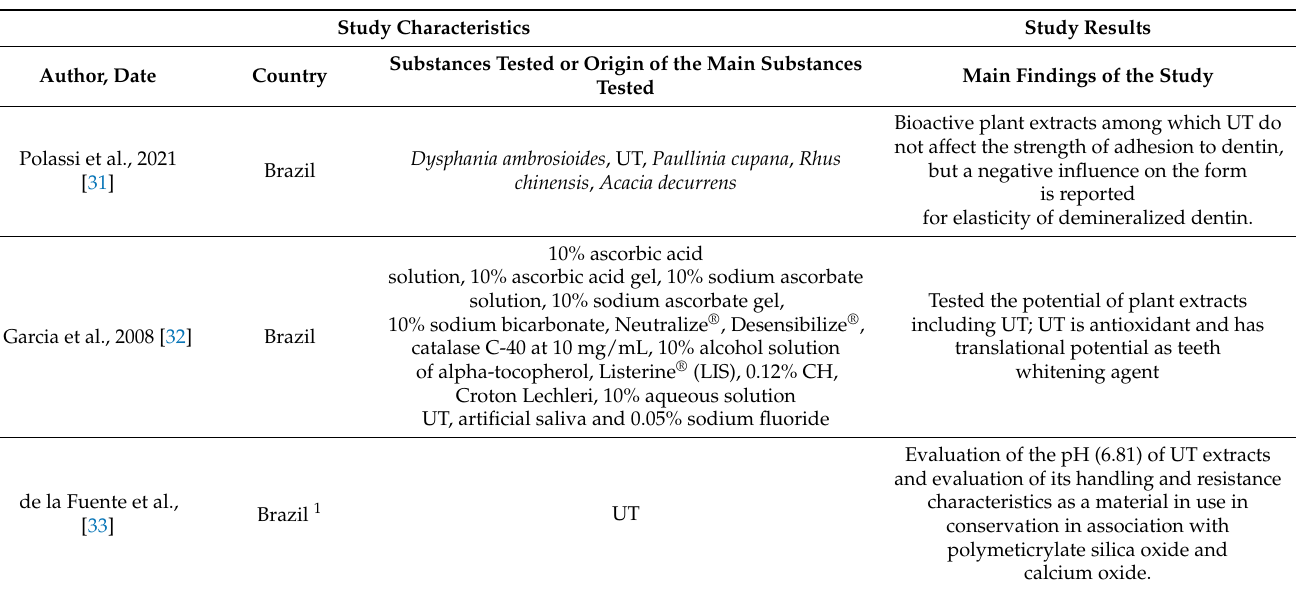
Table 3. Non-microbiological in vitro